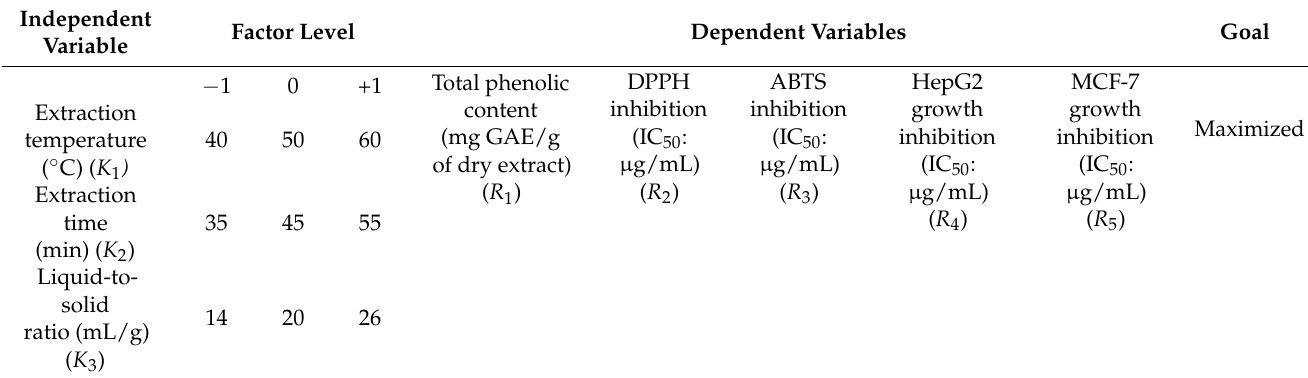
Table 1. Three levels of the three variables of the extraction